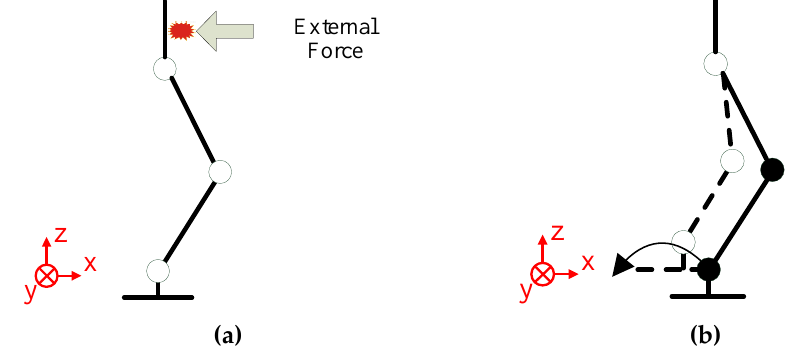
Figure 9. Two situations of the backward balance strategy. ( a ) The robot receives an external force from its front. ( b ) The left foot lifts and swings backward one step.